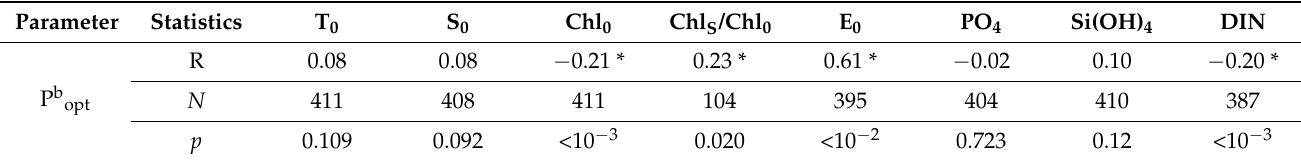
Table 4. The correlation matrix between the log-transformed optimal assimilation numbers for